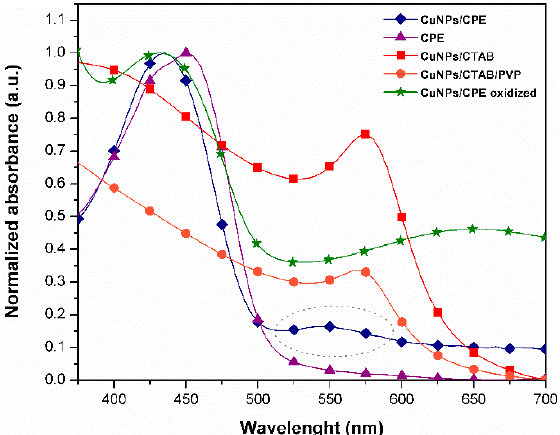
Figure 1. UV-vis spectra of the CPE and the copper nanoparticles (CuNP)/CPE (stabilized and oxidized), CuNP/cetyltrimethylammonium bromide (CTAB), and CuNP/polyvinylpyrrolidone (PVP)/CTAB composites in aqueous suspensions (10 − 4 mol·L − 1 ).